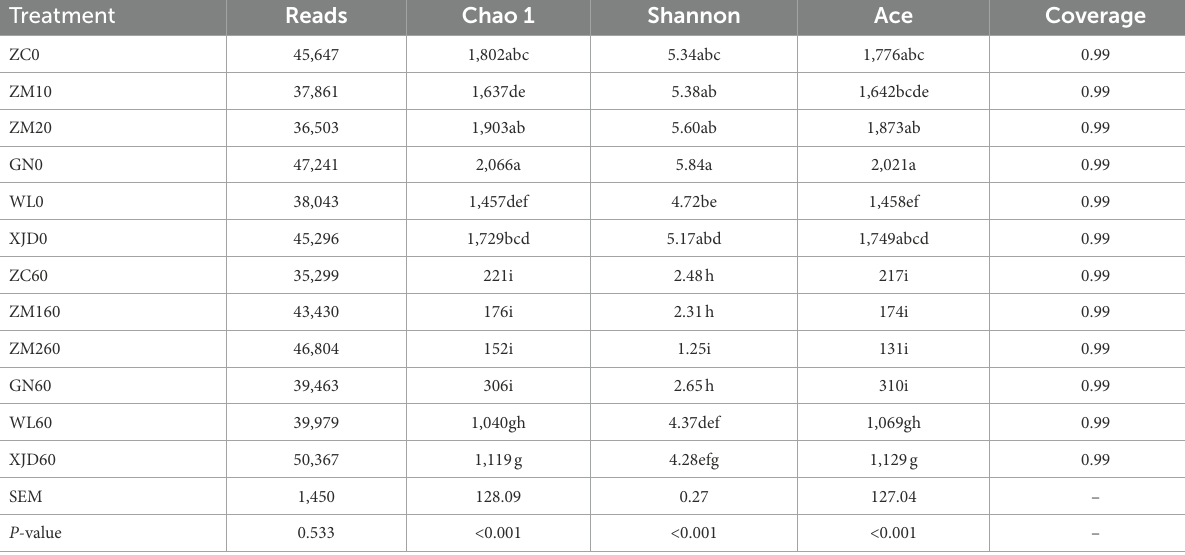
TABLE 4 Alpha diversity of the bacterial community in fresh materials and alfalfa silage. Treatment